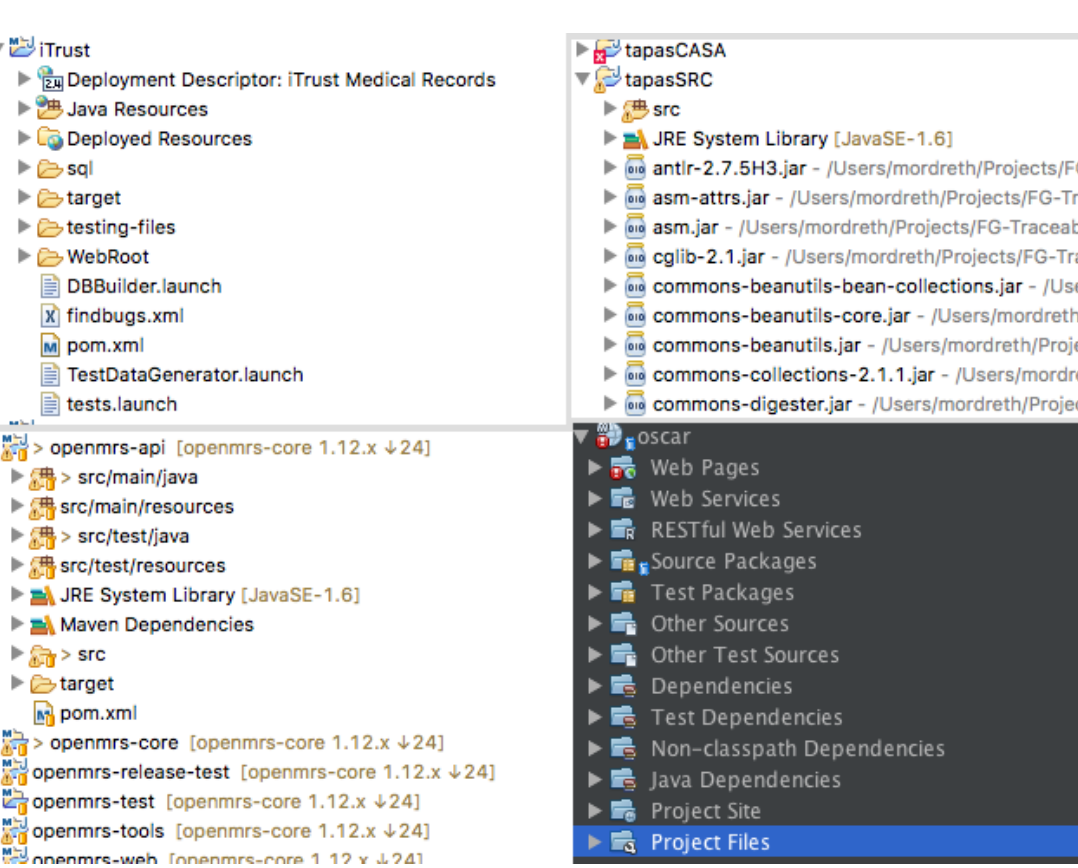
Figure 1: Overview of source package organization for each of the healthcare systems selected in the this study. On left top, iTrust source packages, right-top TAPAS source packages, bottom-left OPENMRS source packages, bottom-right OSCAR source